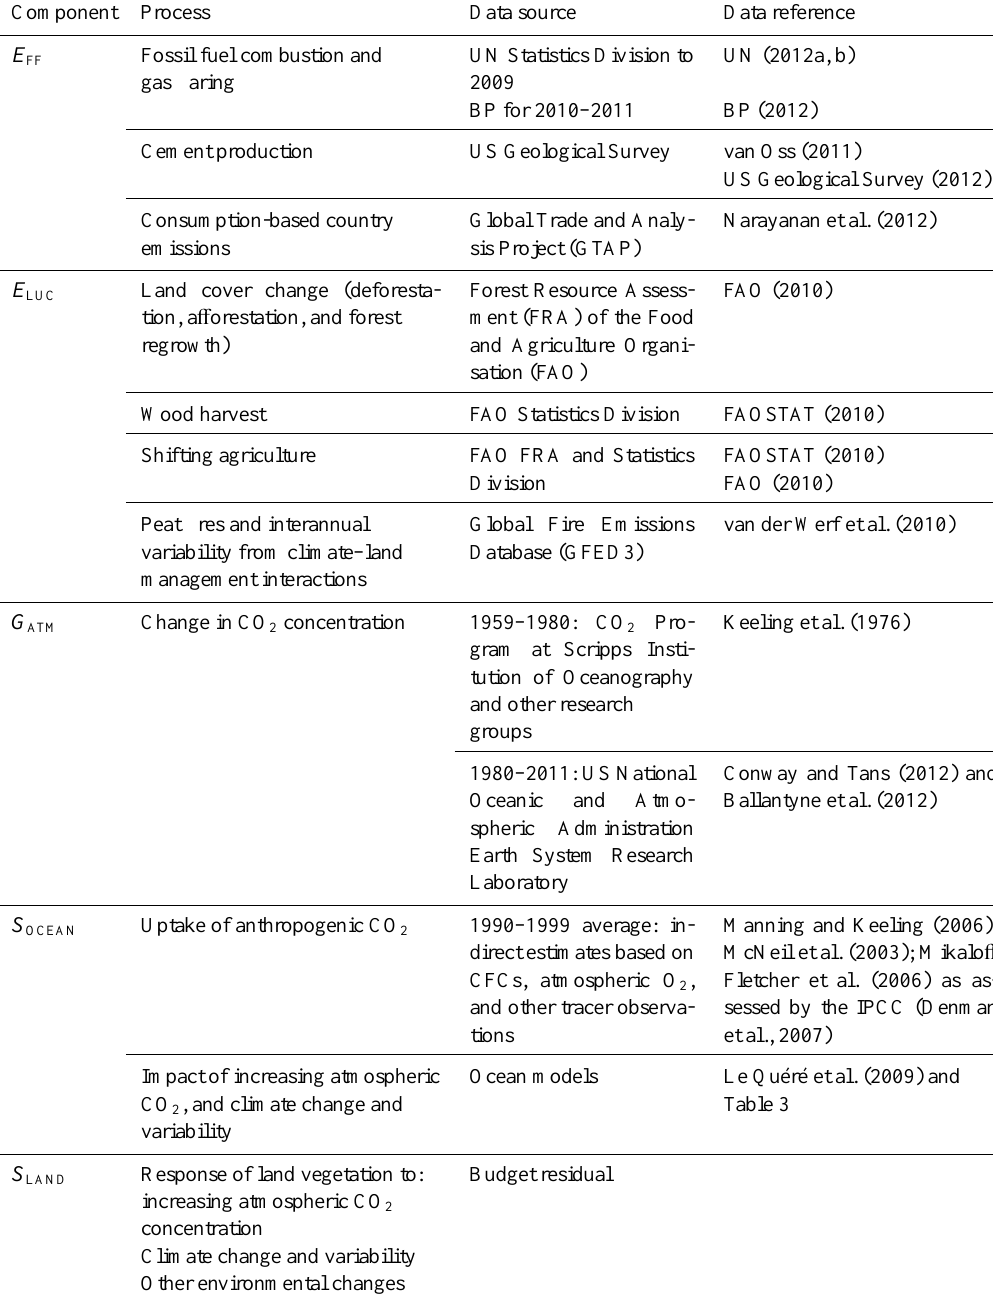
Table 1. Data sources used to compute each component of the global carbon